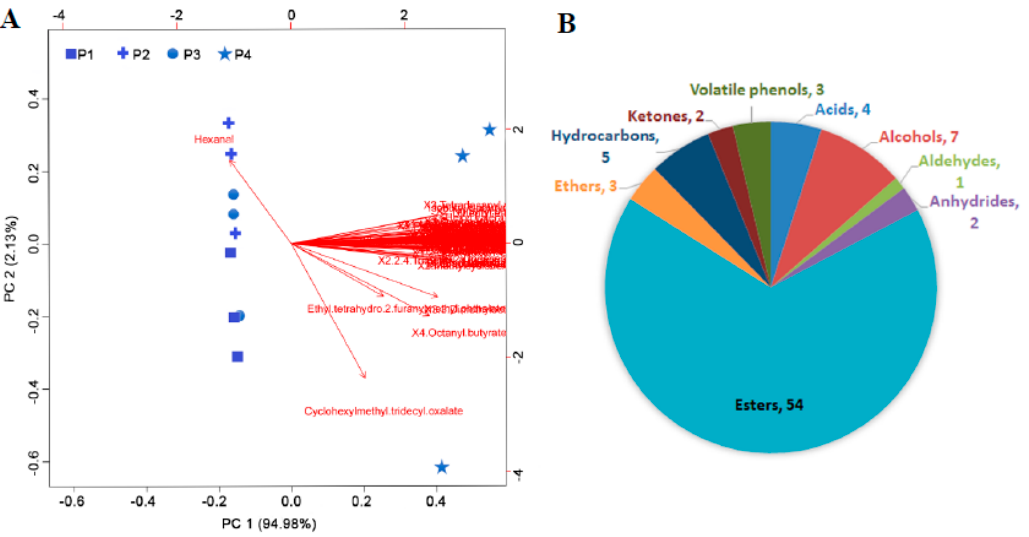
Figure 6. ( A ) Principal component analysis of differentially accumulated volatile compounds in the peel of banana fruit at different stages of ripening. All those compounds were specifically accumulated at P4 except one aldehyde. Detailed information is shown in Supplementary Table S1. ( B ) Classification of differentially accumulated volatile compounds in the peel of banana fruit at different stages of ripening